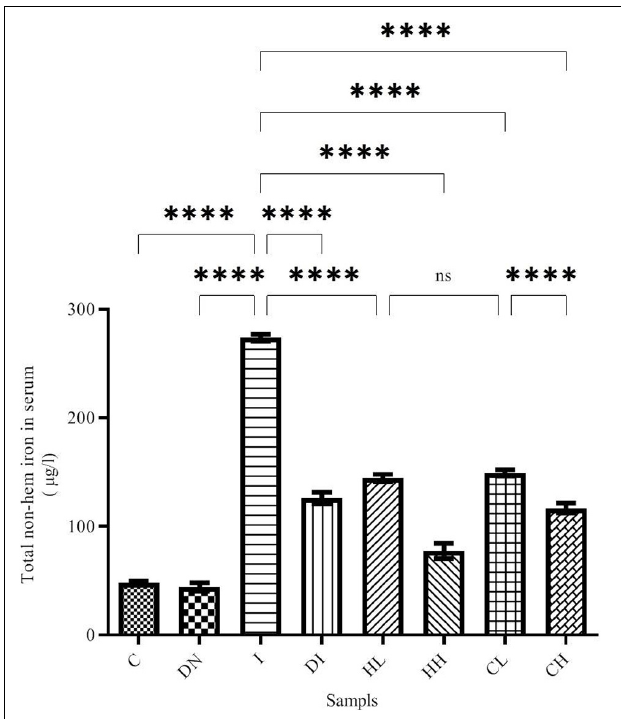
FIGURE 2 | Brain tissue’s non-heme iron content in the treated mice, Group C, control group: Normal saline-receiving group; Group DN, normal saline and deferoxamine-receiving group; Group I, iron dextran and normal saline-receiving group; Group DI, iron dextran and deferoxamine-receiving group; Group HL, low dose hesperidin-receiving group; Group HH, high dose hesperidin-receiving group; Group CL, low dose coumarin-receiving group; and Group CH, high dose coumarin-receiving group (Mean ± SD; ∗∗∗ p ≤ 0.001, ∗∗∗∗ p ≤ 0.0001, ns: